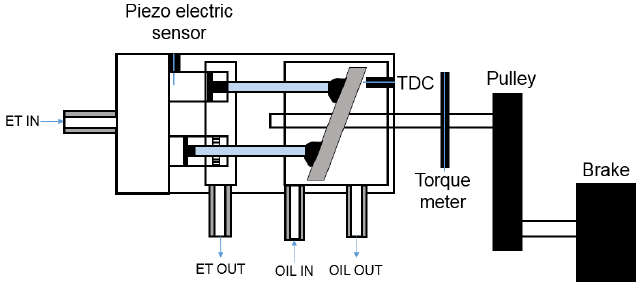
Figure 5. Swash-plate expander scheme. TDC: top dead center.